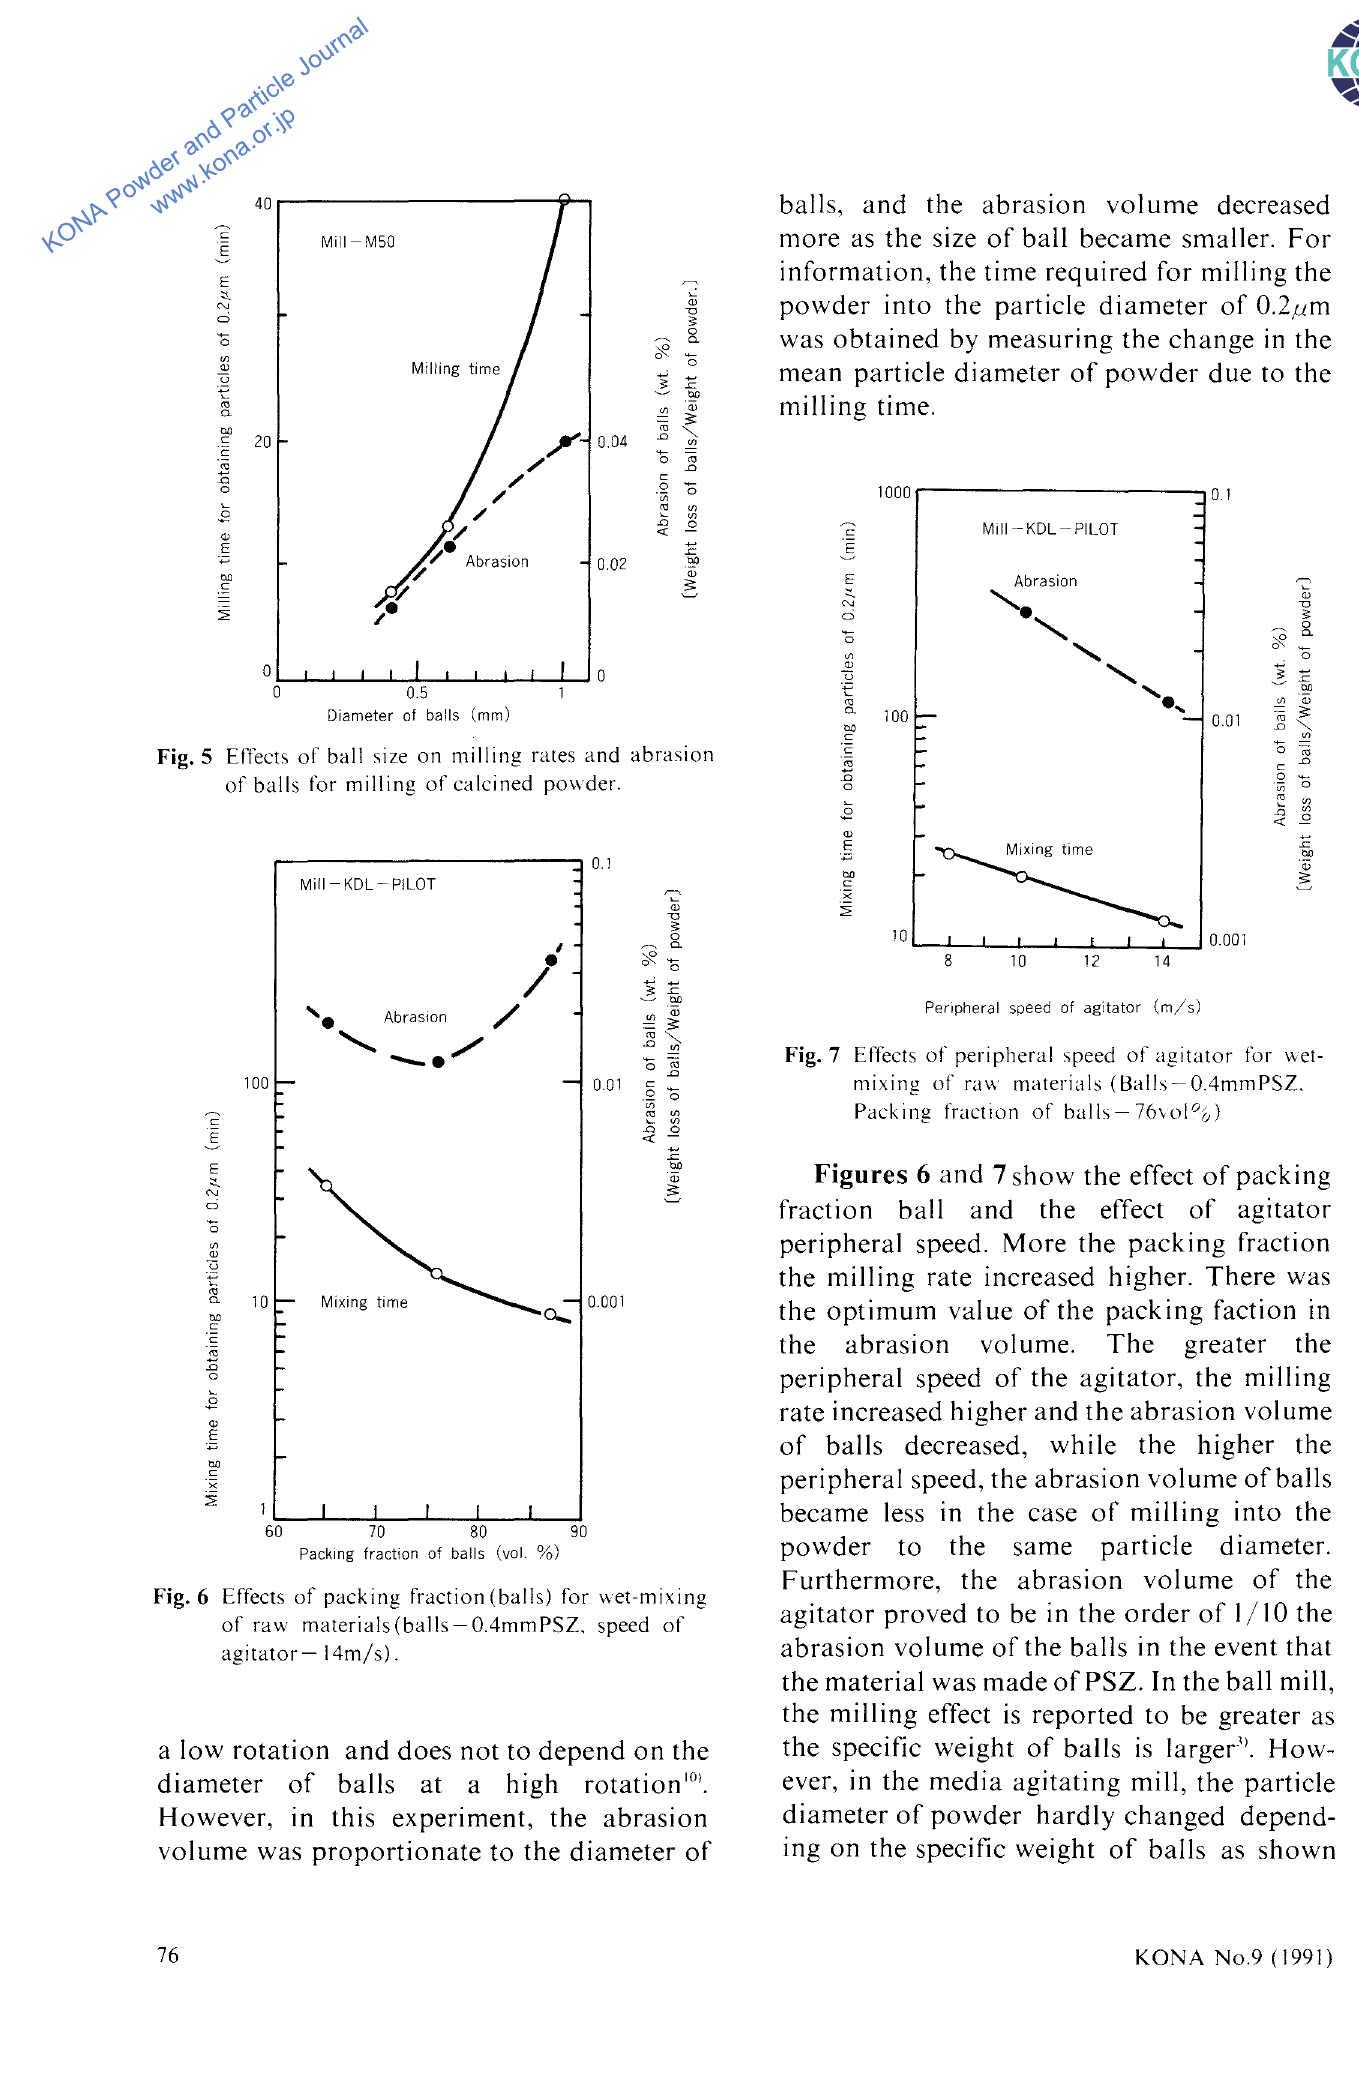
Fig. 6 Effects of packing fraction (balls) for wet-mixing of raw materials(balls-0.4mmPSZ. speed of agitator-14m/s).